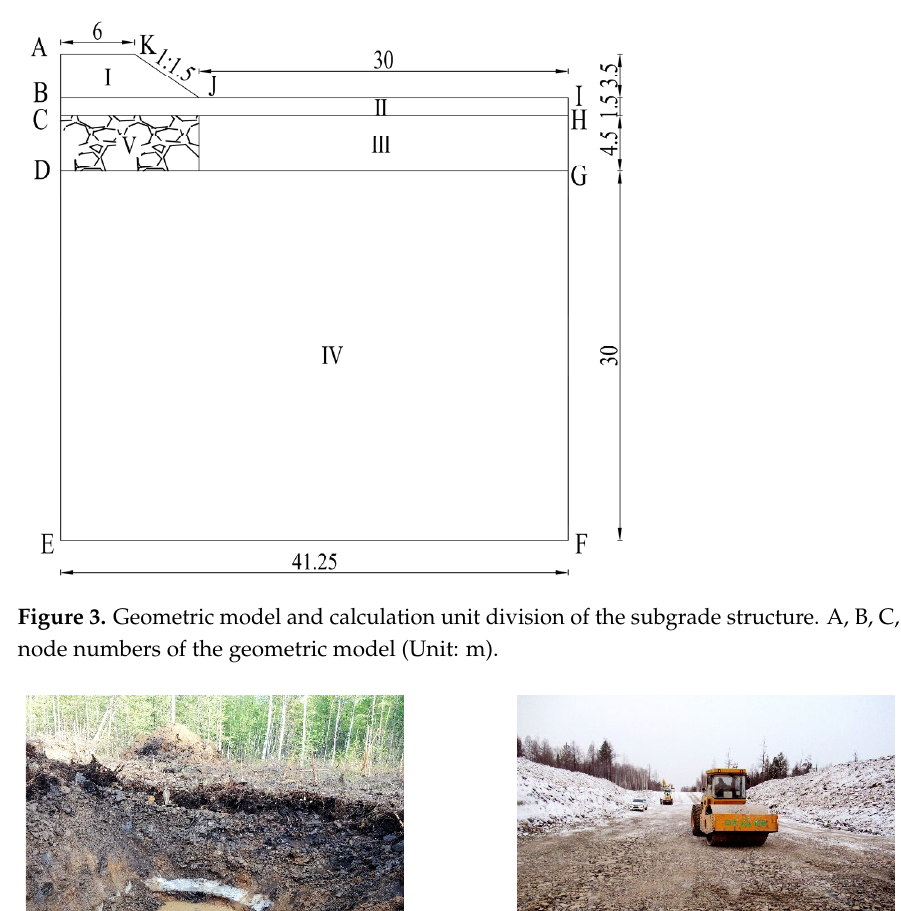
Figure 3. Geometric model and calculation unit division of the subgrade structure. A, B, C, and D are node numbers of the geometric model (Unit: m).